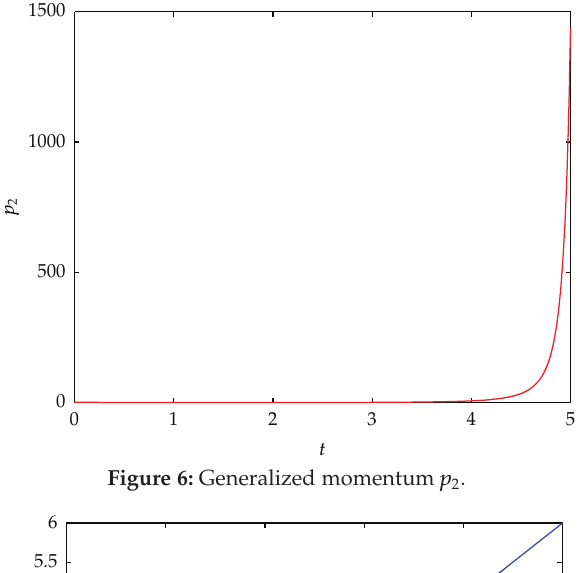
Figure 6: Generalized momentum p 2 .